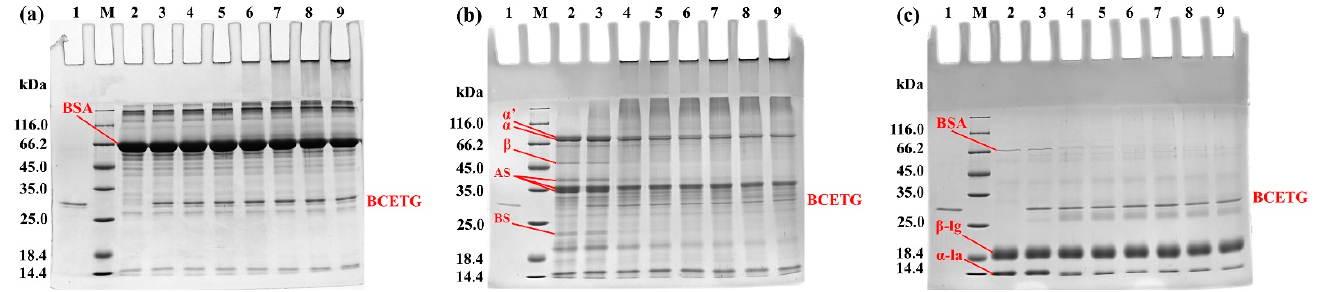
Figure 6. The electrophoretic arrangements of the native and BCETG-treated ( a ) BSA, ( b ) SPI, and ( c ) WP. Lane M, protein standard ladder; Lane 1, the purified BCETG; Lane 2, the native BSA, SPI, or WP; Lane 3–9, BCETG-treated BSA, SPI, or WP for 0–6 h.